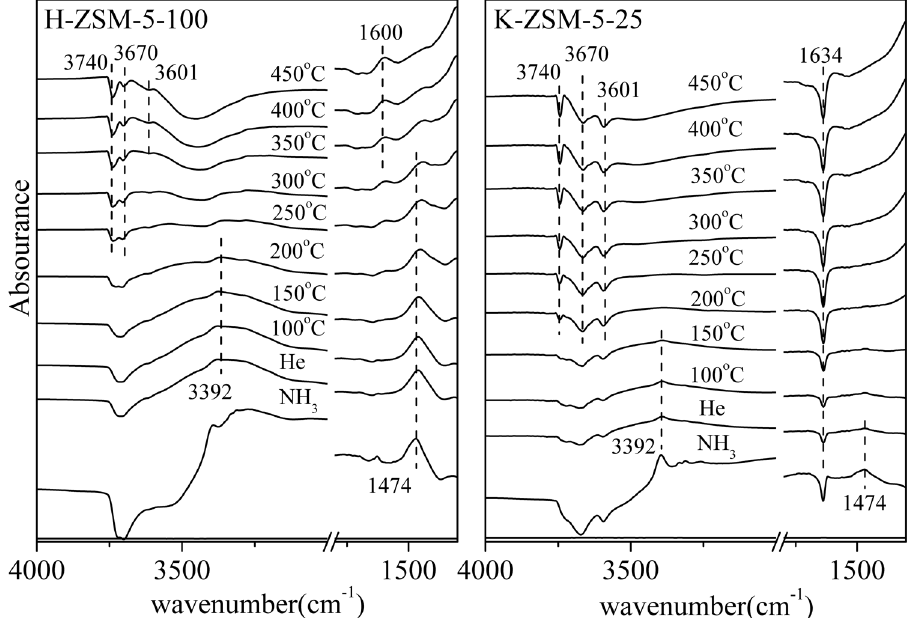
Figure 5. In situ IR spectra of NH 3 desorption in He.